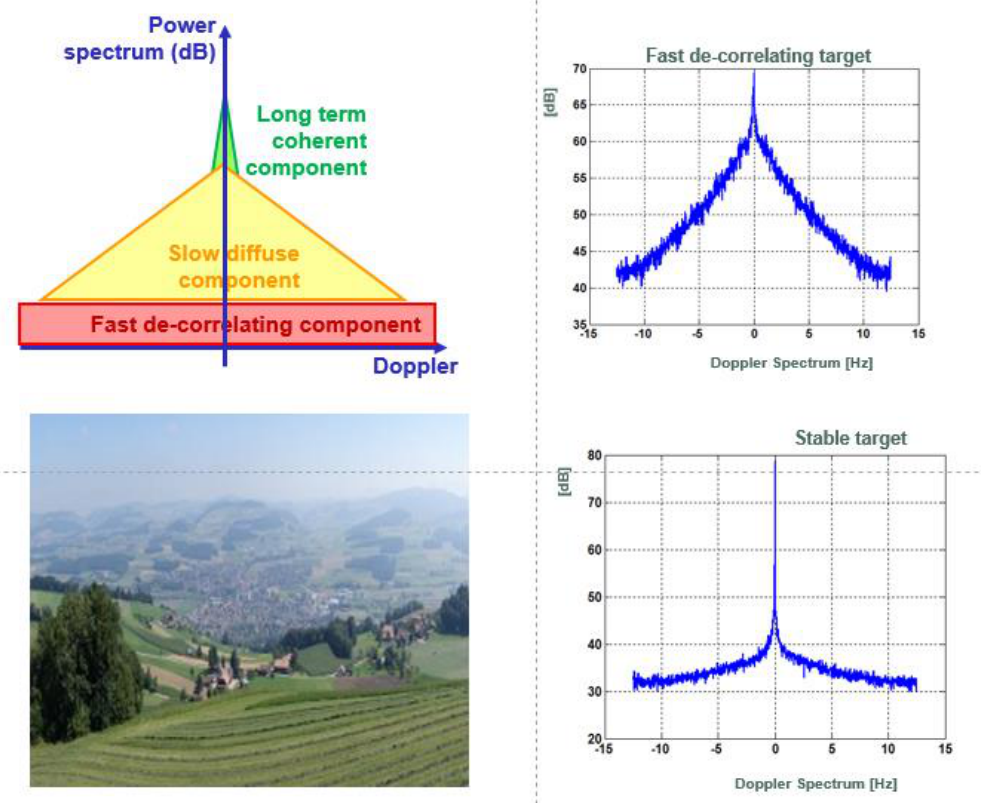
Figure 1. Intrinsic Clutter Model (ICM) model, top left, and measures of Doppler Power Spectrum Density (PSD) by Ku band Ground-Based Radar (GBR) in a rural scene (bottom left), of a fast decorrelating target, top right, and a stable target, (bottom